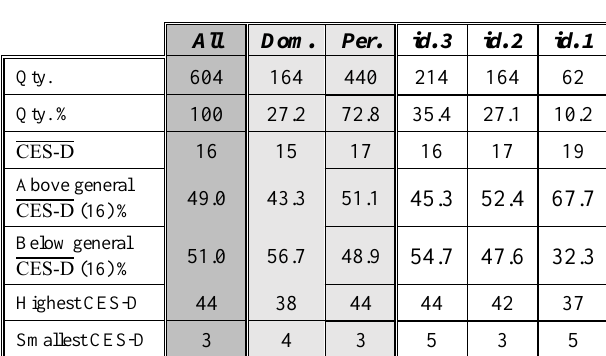
Table 2 : Overall results